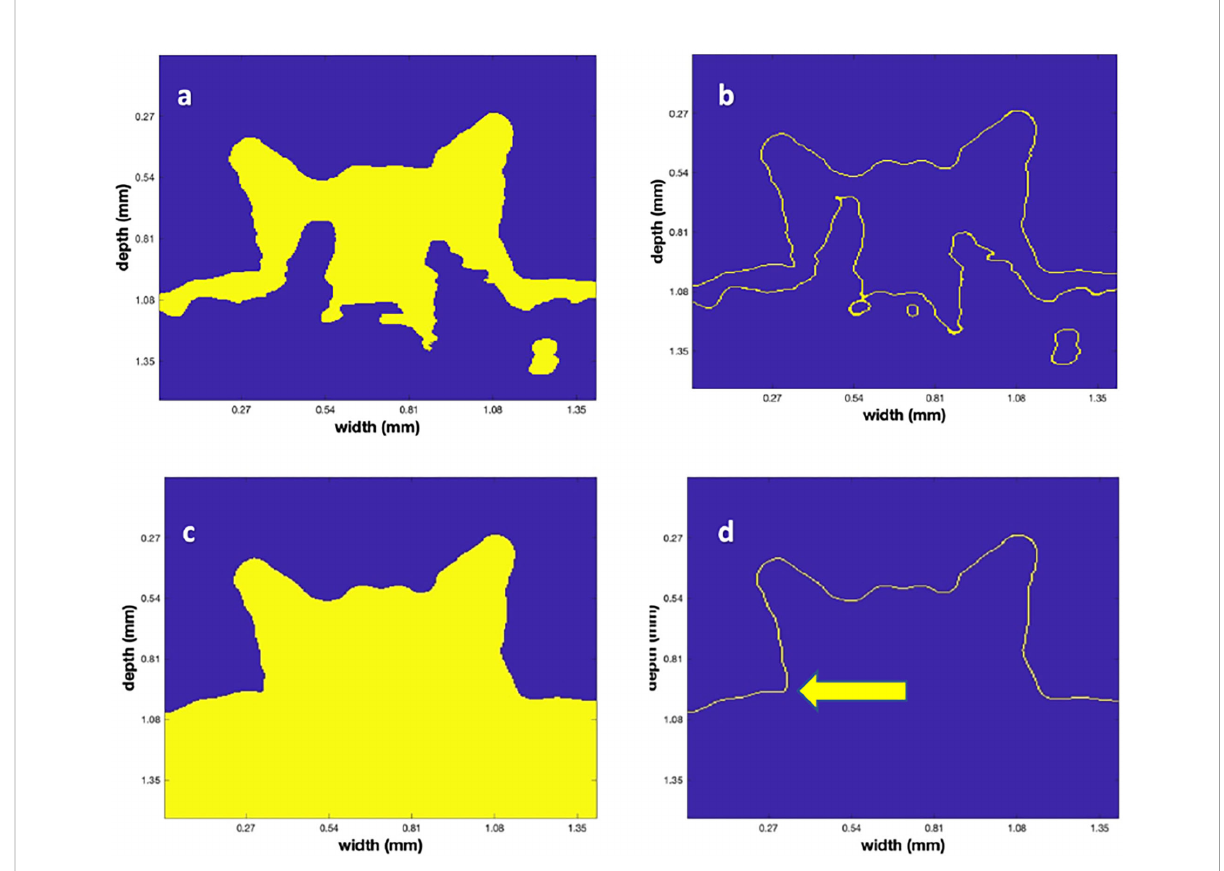
FIGURE 5 The successive steps in the surface identi fi cation algorithm. (A) The vertical plane, as in Figure 4D, after the mathematical morphological operations. (B) The result of applying the Canny edge detector to (A) . (C) The result of the region fi ll operation after choosing a seed above the polyp. Note that the blue values are the fi lled region. (D) The fi nal surface determined from the Canny edge detector applied to (C) . The arrow indicates a vertical location that was manually chosen to be the bottom of the polyp to permit the volume